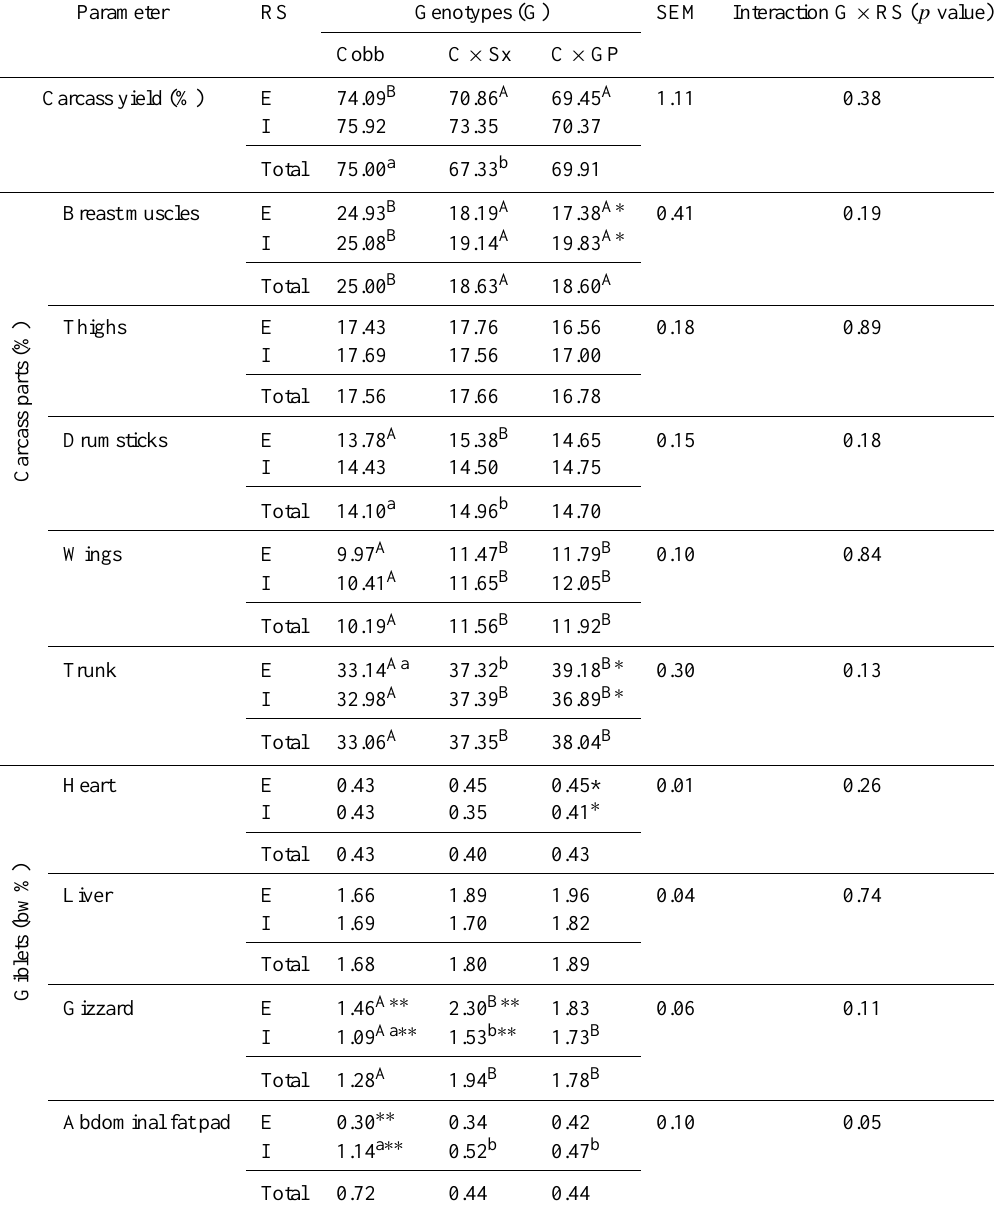
Table 5. The results of birds’ dissection